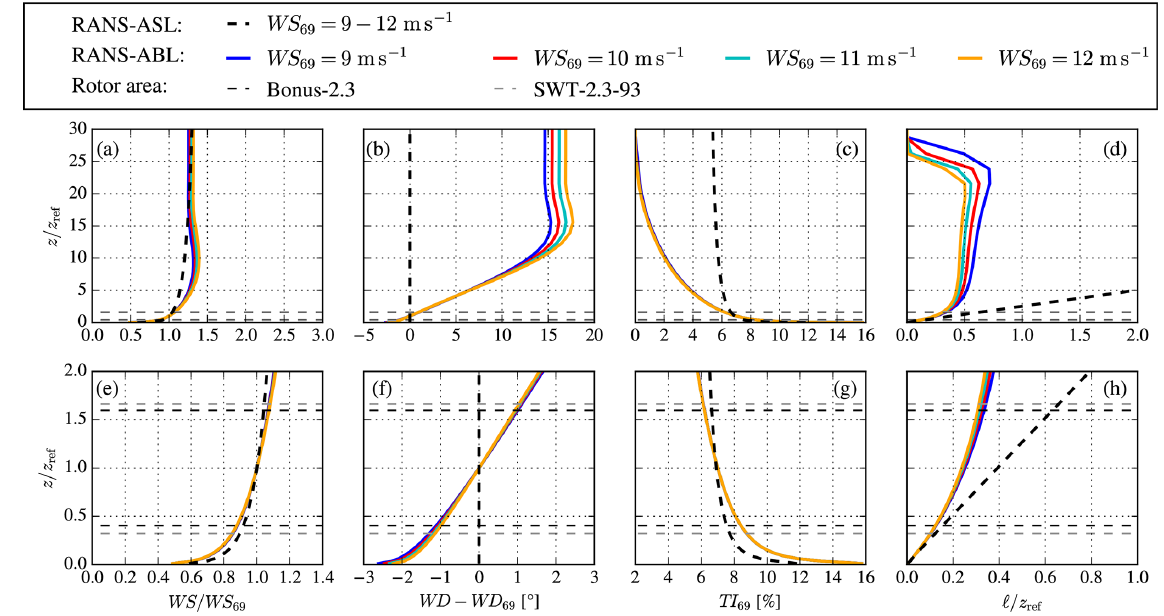
Figure 5. Inflow profiles for RANS simulations. Panels (e–h) are a zoomed view of (a–d) , focused around wind turbine rotor areas, which are depicted as black (Bonus-2.3) and grey (SWT-2.3-93) dashed lines. (a, e) Wind speed (WS); (b, f) wind direction (WD); (c, g) turbulence intensity (TI); and (d, h) turbulence length scale ( (cid:96) ).